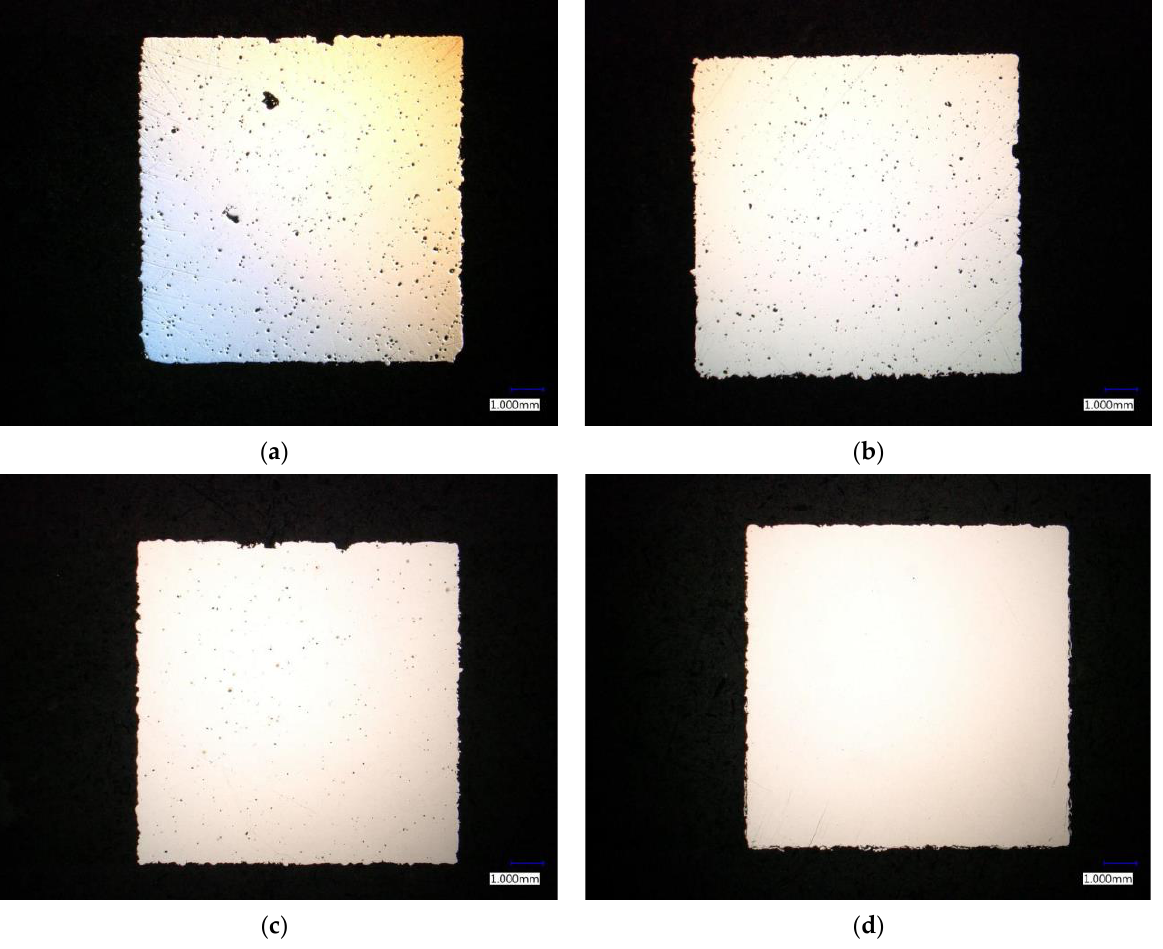
Figure 11. Images of metallographic sections ( a ) sample No. 46 (1st step); ( b ) sample No. 64 (1st step); ( c ) sample No. 15 (2nd step); ( d ) sample No. 64 (2nd step). Table 11. The resulting relative density of selected samples after the 1st step.